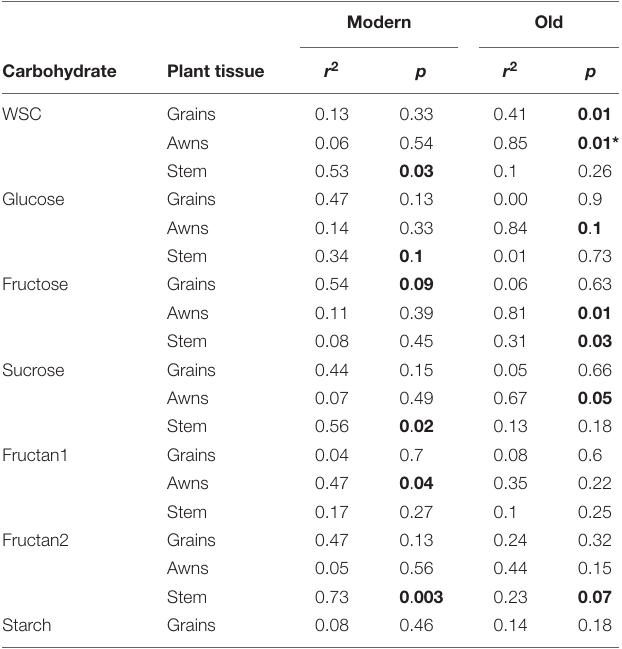
TABLE 2 | r 2 and p -values of linear regressions between individual carbohydrates’ concentrations in different plant organs at 12 DAA and final grain weight per plant, in modern or older